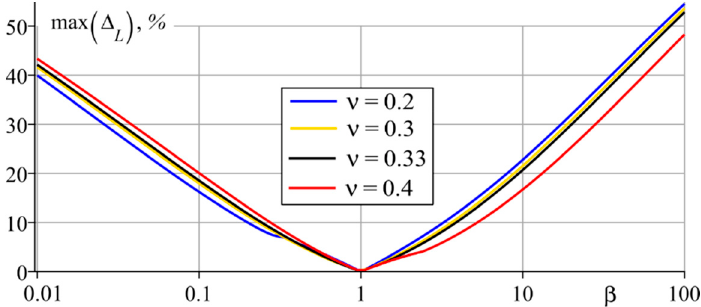
Figure 3. Graphs of a maximum relative error max( Δ L ( u )) of the simplified approximation of the kernel transform versus relative elastic parameter β .